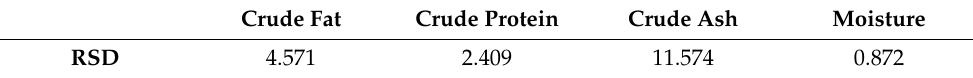
Table 6. Composition value prediction and RSD with EIS